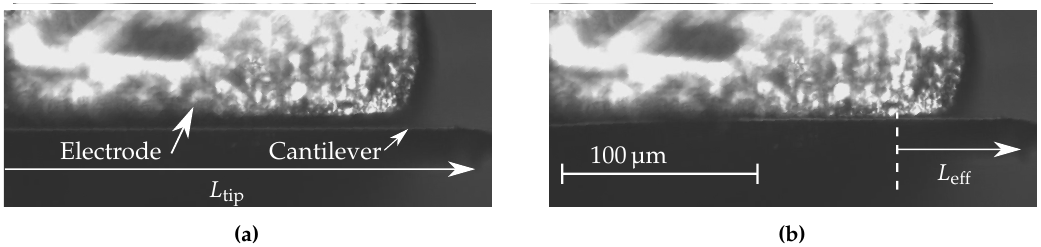
Figure 7. Side view of the electrode and the cantilever obtained with an optical microscope. ( a ) before stiffness adjustment; ( b ) after stiffness adjustment. The clamped side of the cantilever is located at the left (not shown). These positions correspond to the ones shown in Figure 2.